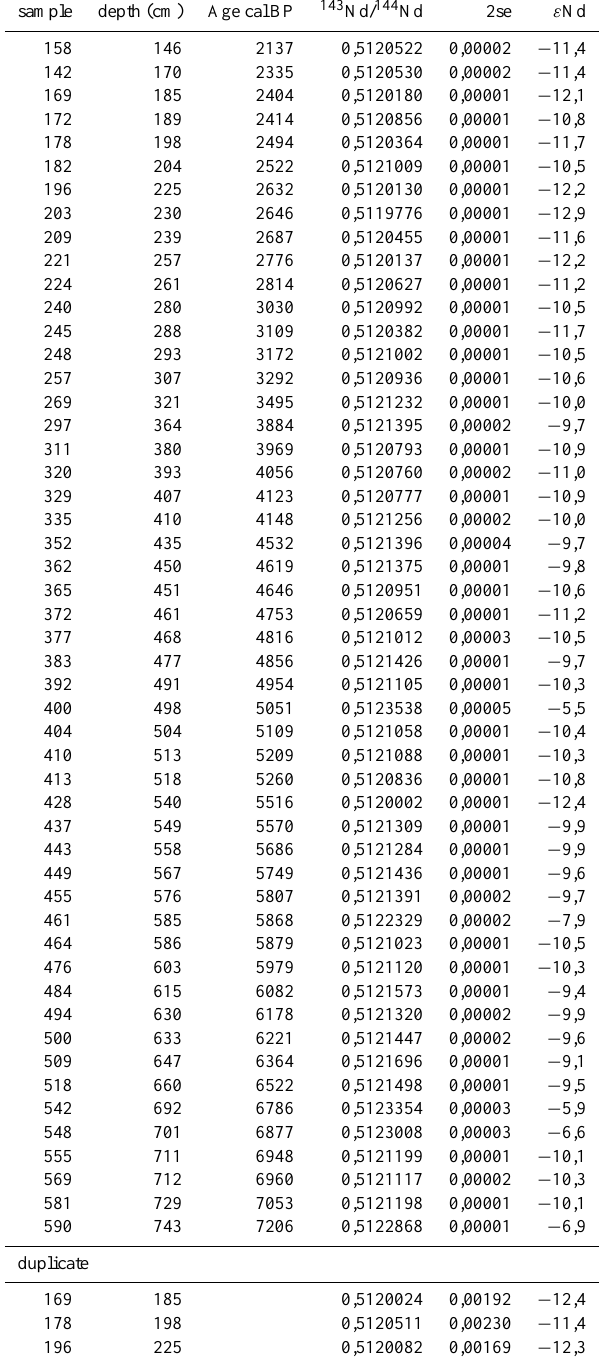
Table 1. Sm–Nd analytical results of the samples from the Misten peat.